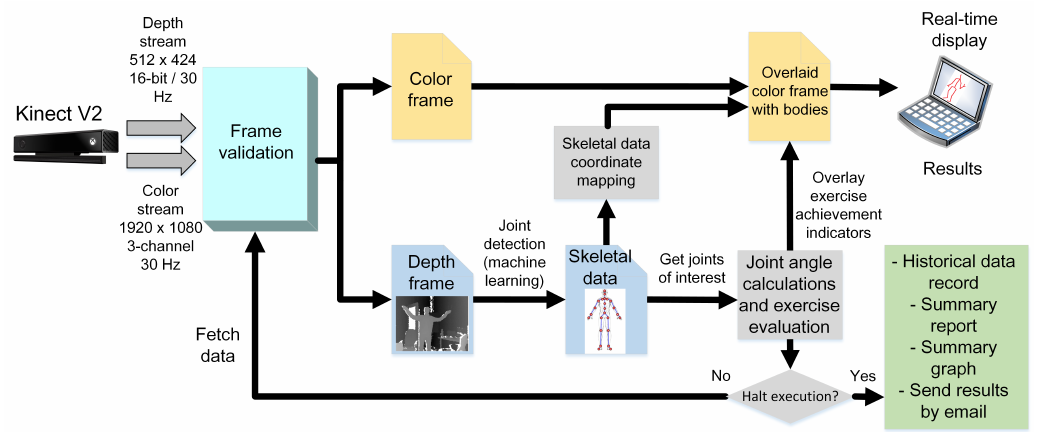
Figure 1. HemoKinect flowchart describing the implemented methodology. The depth frames are processed to obtain the skeletal data from them using a machine learning algorithm, in particular a random decision forest [38]. The skeletal data are then mapped to the color image space using methods coded in Microsoft’s SDK. Then, the overlay image is obtained by drawing the bodies on top of the color image and adding the calculated angles’ achievement indicators. The process continues until the execution is halted. Finally, summary reports and graphs of the exercise are